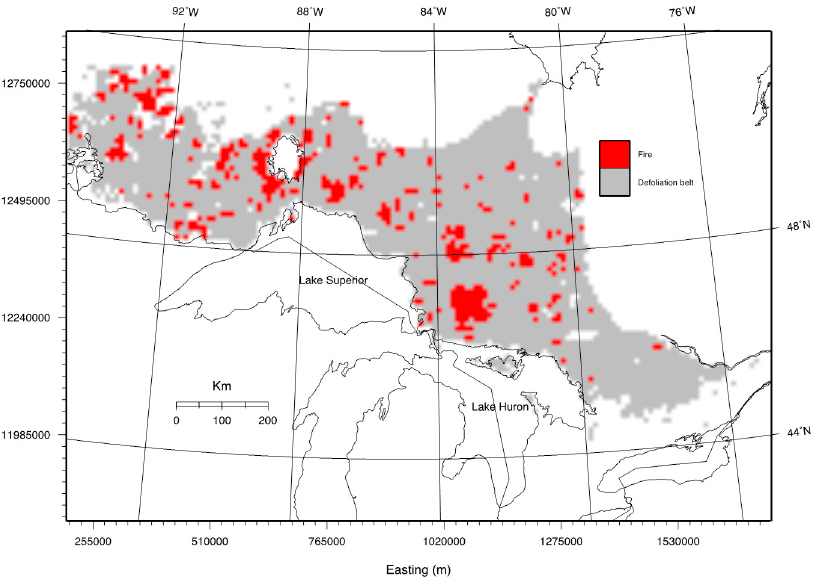
Figure 2. ‘Likely interactions’ (in red) of spruce budworm defoliation and large (>2 km 2 ) fires in the spruce budworm belt (gray) mapped on a 10-km grid for 1941–2005.